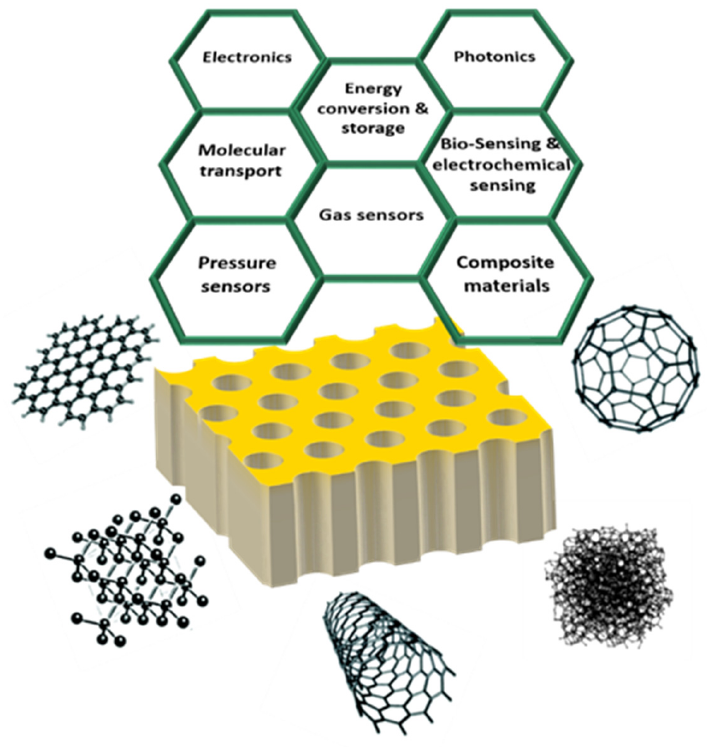
Figure 29. Various applications developed over the years based on PAA/CNTs assemblies.